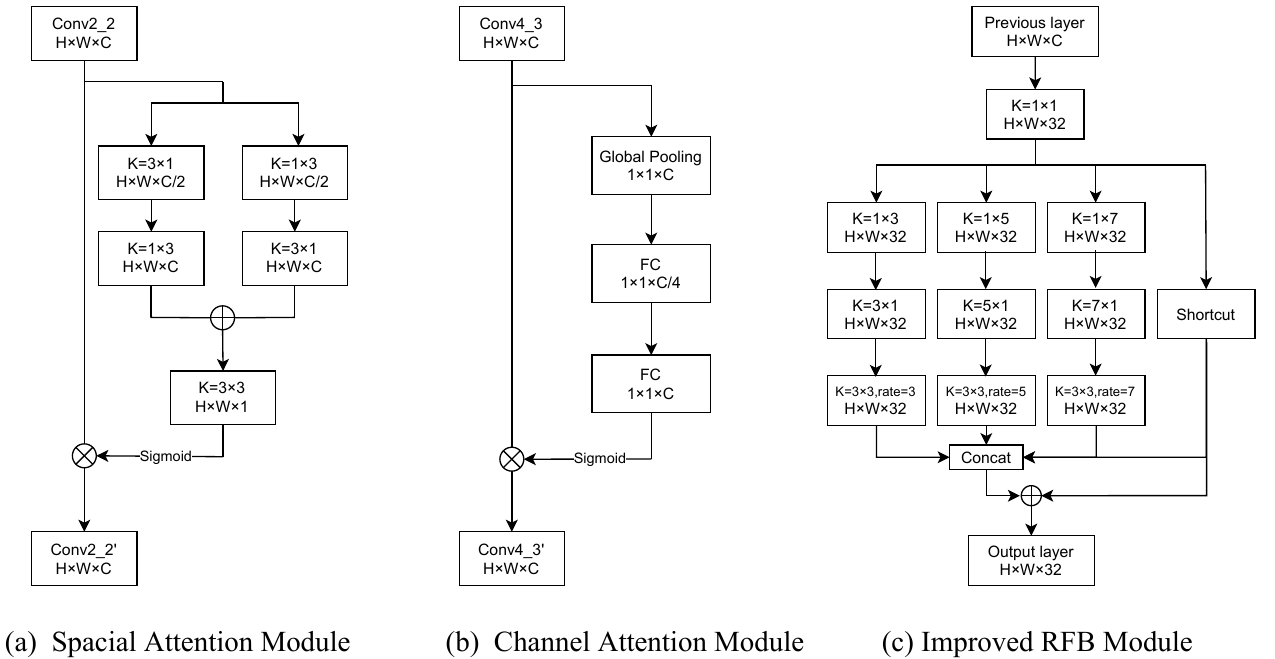
Figure 2. The detailed structure of the function module. Among them, the spatial attention module ( a ) and channel attention module ( b ) are used to filter out high-quality features. The improved RBF module ( c ) enriches the decoding information by increasing the receptive